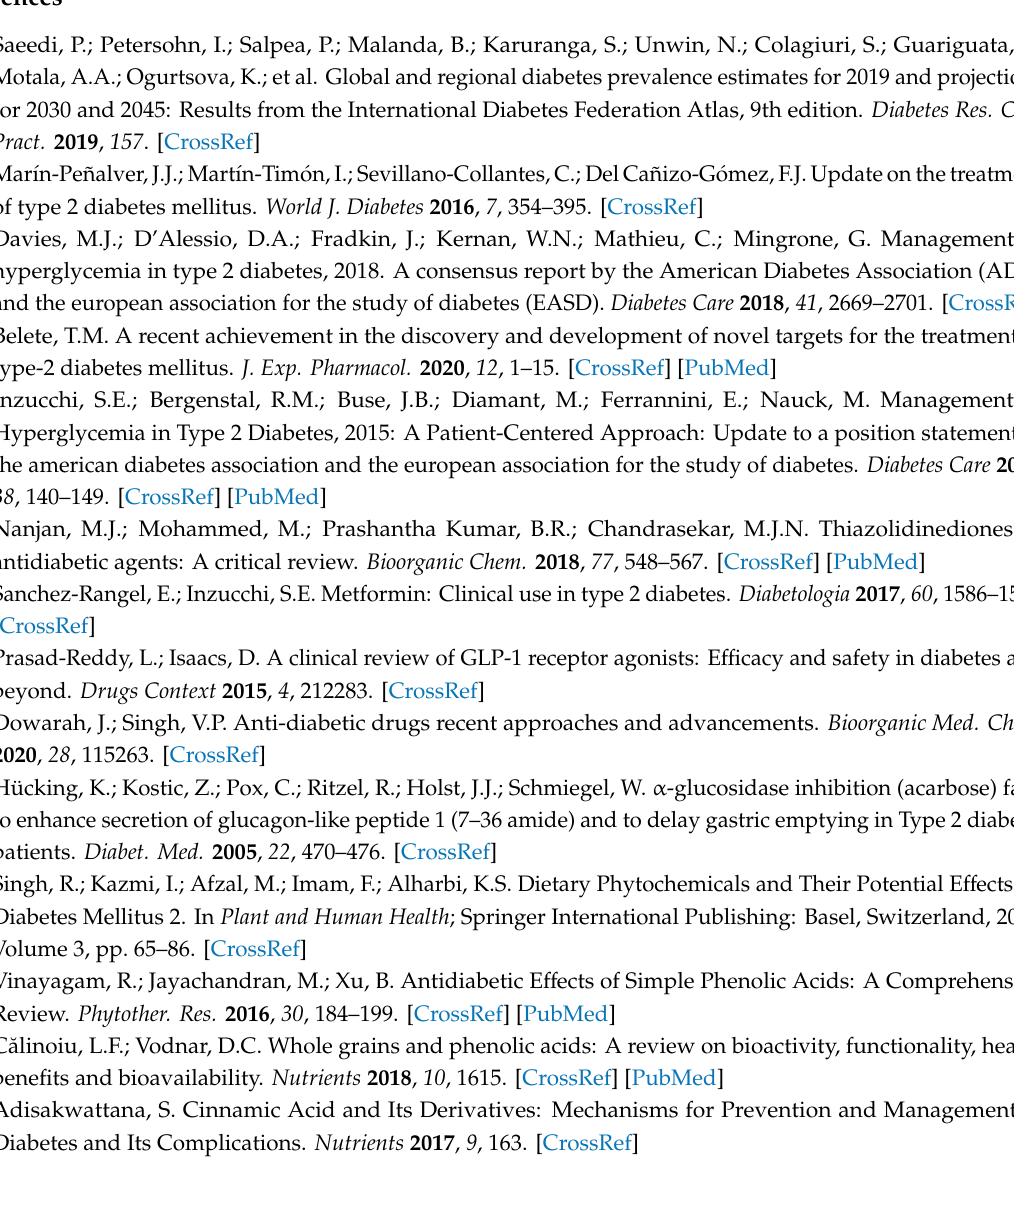
Figure S1: 1 H NMR spectrum, Figure S2: 13 C NMR spectrum, Figure S3: 31 P NMR spectrum, Figure S4: 1 H– 1 H COSY spectrum, Figure S5: HSQC